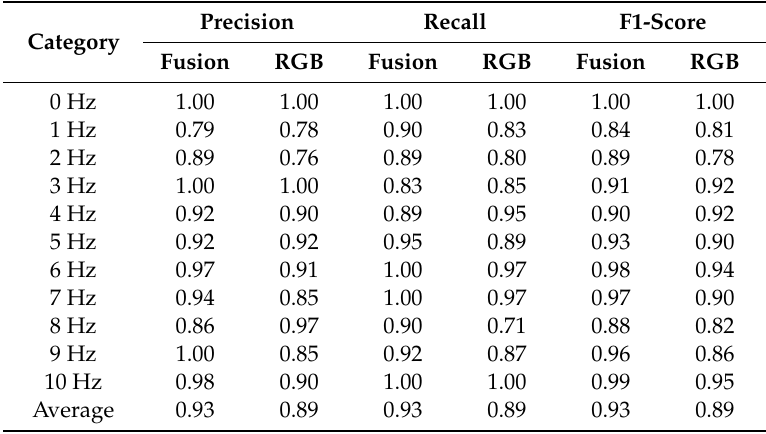
Table 4. Evaluation indicator results of the muti-modal fusion and RGB